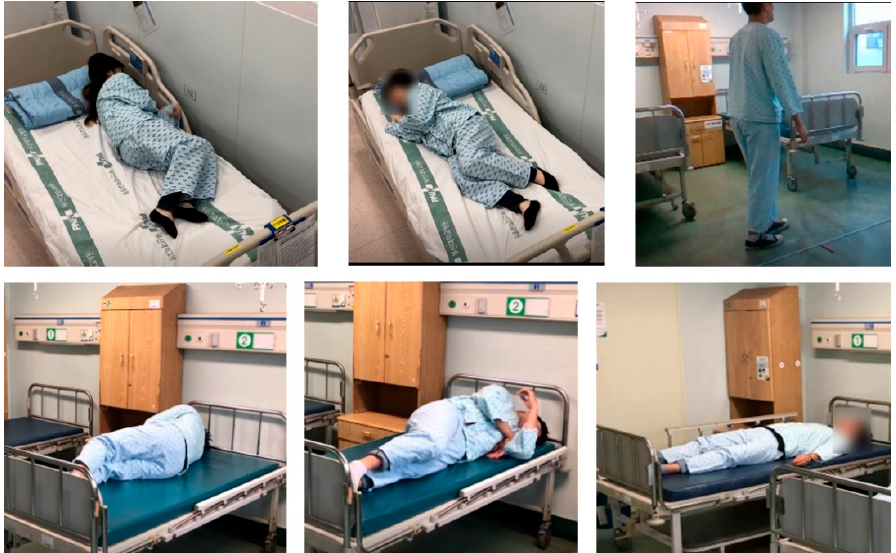
Figure 9. The image of the hospital room and patient in various positions from different directions.